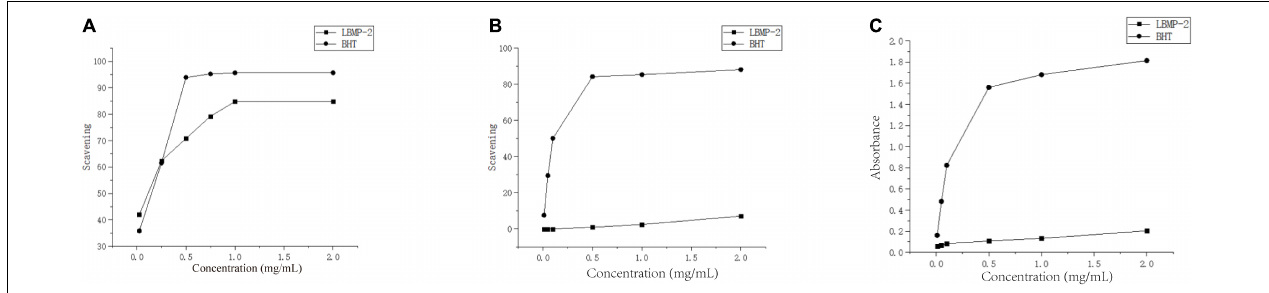
FIGURE 2 | Antioxidant activities of LBMP-2 in vitro . (A) Scavenging abilities on DPPH radicals. (B) Scavenging abilities on ABTS radicals. (C) Reducing power.